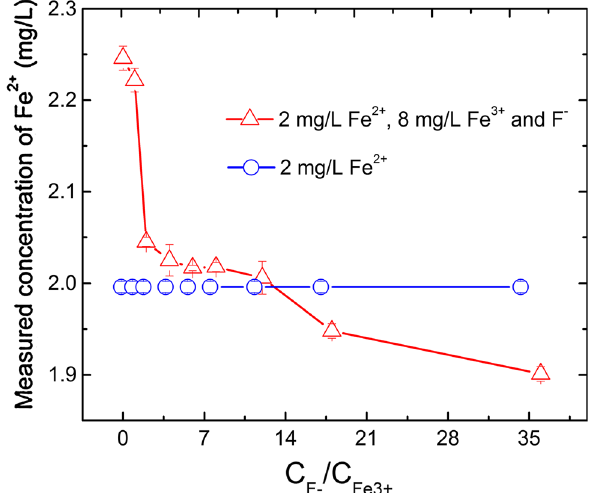
Fig. 2 Effect of dosage of F − on the determination of Fe 2+ in the presence of Fe 3+ . Experimental conditions: 2 mg/L Fe 2+ , 8 mg/L Fe 3+ and with or without the addition of F − ; C F− /C Fe3+ was molar concentra- tion